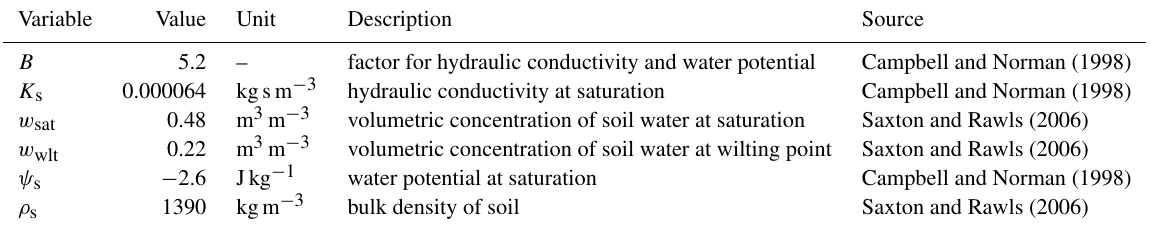
Table 5. Soil-type specific parameters.